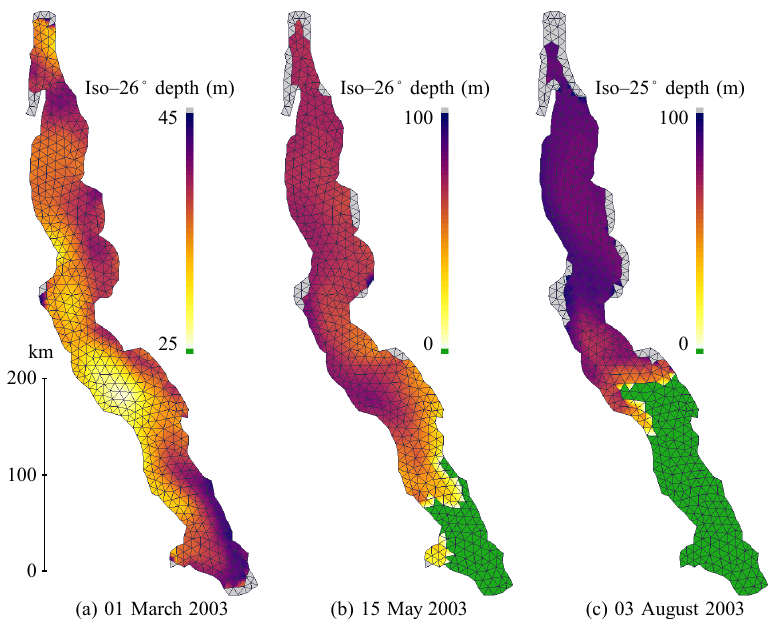
Figure 20. Isotherm depths in Lake Tanganyika on 1 March (26 ◦ C), 15 May (26 ◦ C) and 3 April (25 ◦ C). It is important to note that range of the colour bar is not the same through the different maps. Regions in gray represent areas where the bottom water is warmer than the limit temperature. Green regions represent outcropping